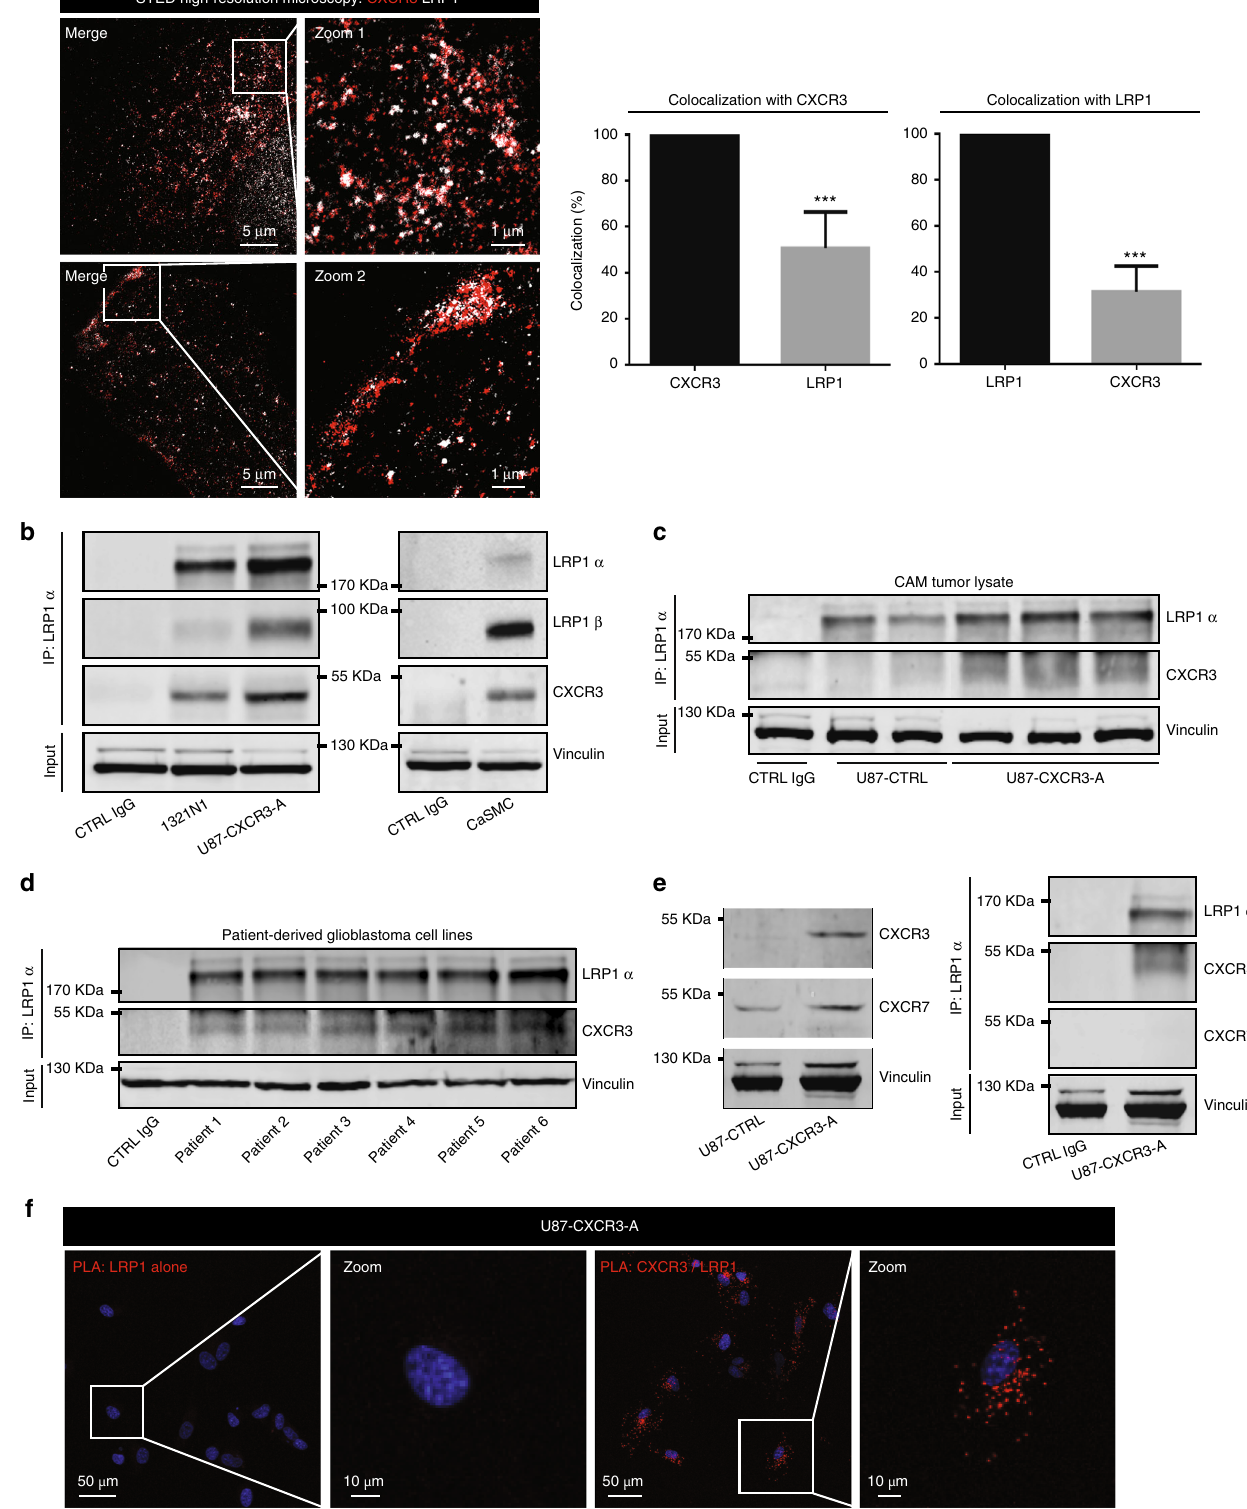
PLA: CXCR3 / LRP1 ZoomPLA: LRP1 alone